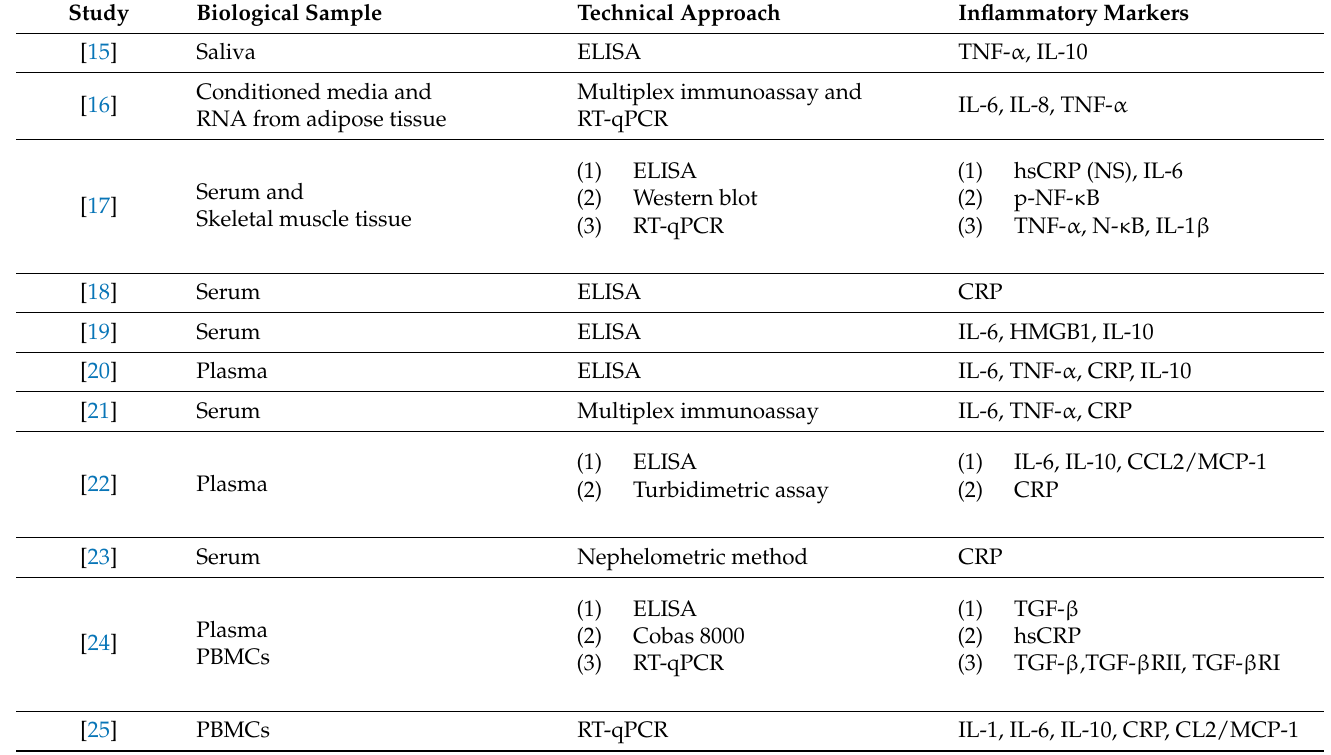
Table 3. Experimental characteristics of the studies included in the systematic